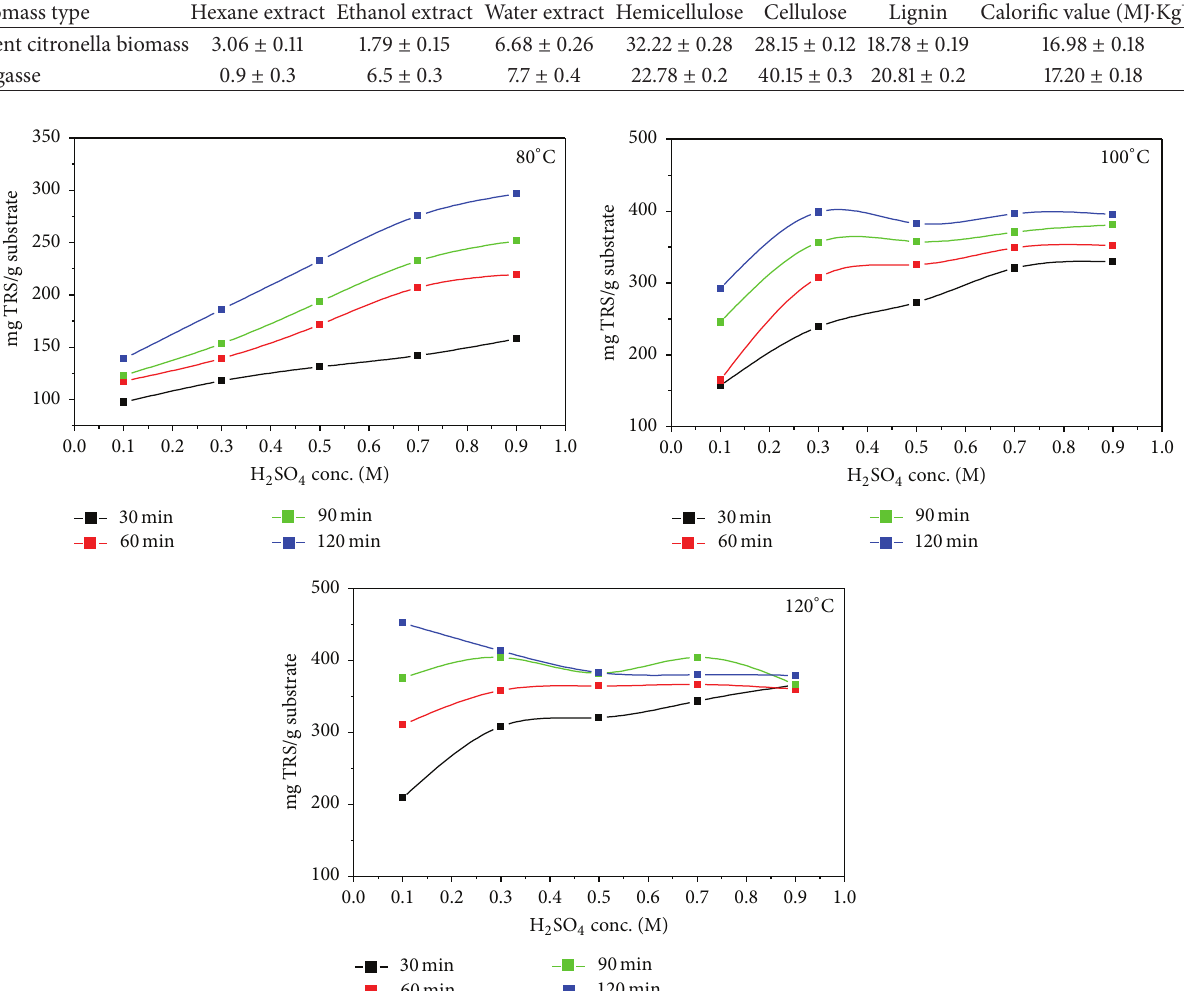
Table 1: Extractives (g) from 100 g biomass sample.